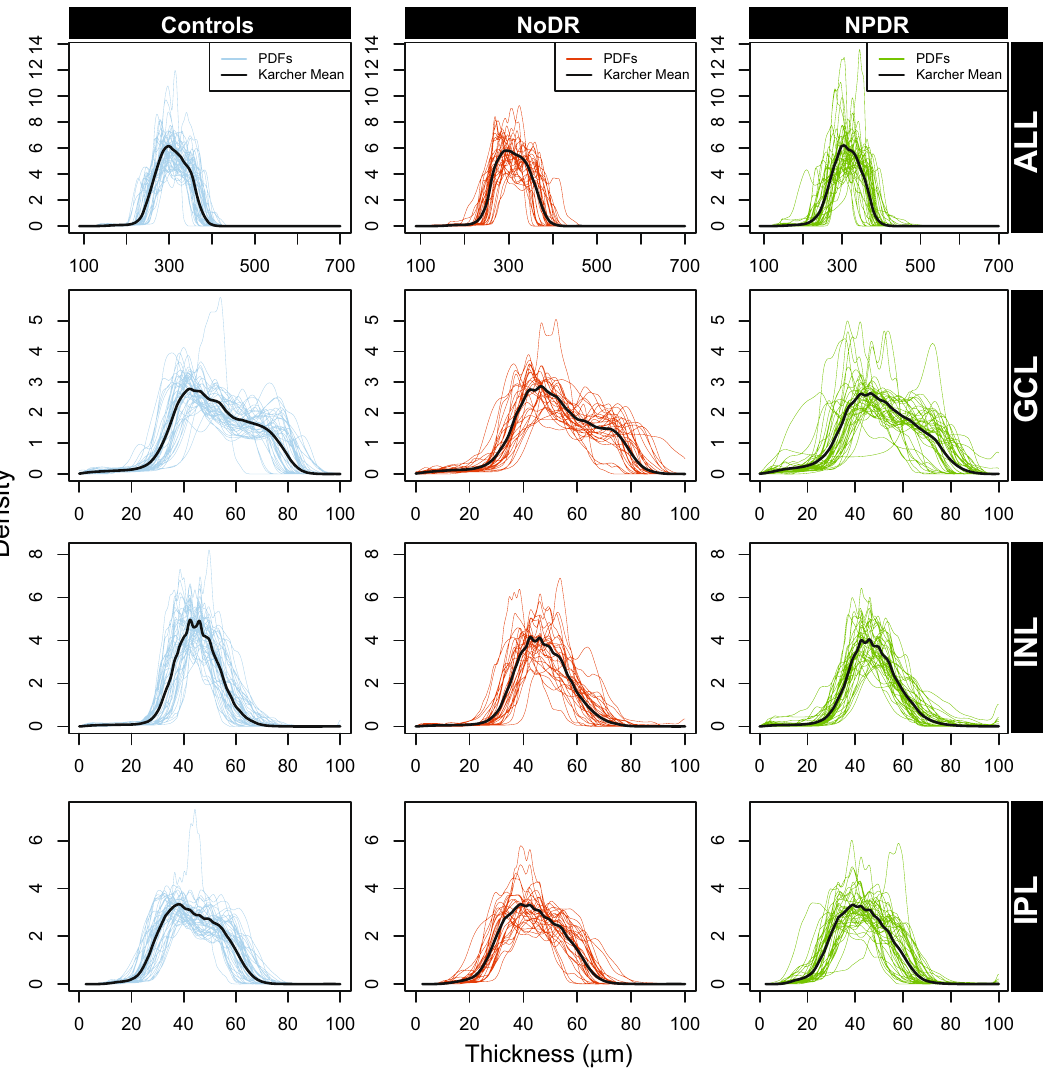
Figure 2. The PDFs of overall thickness (ALL), GCL, INL and IPL, corresponding to the subjects in each of the three categories: controls, NoDR and NPDR. The solid black line represents the Karcher mean of the PDFs corresponding to the subjects in each